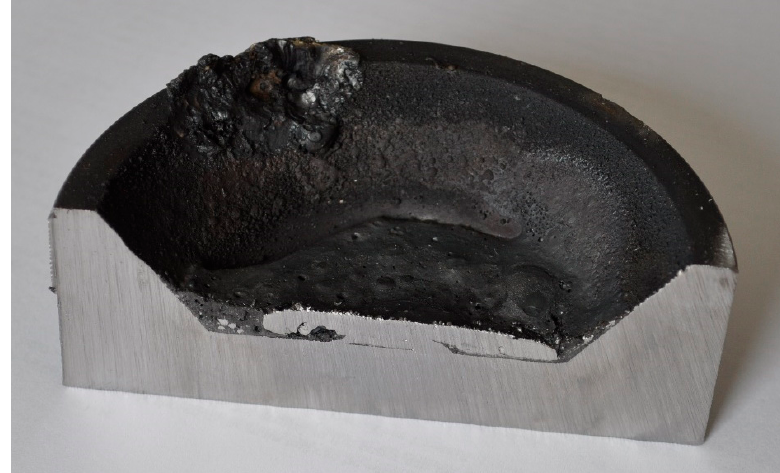
Figure 5. Cross-section of the crucible for Experiment 1.